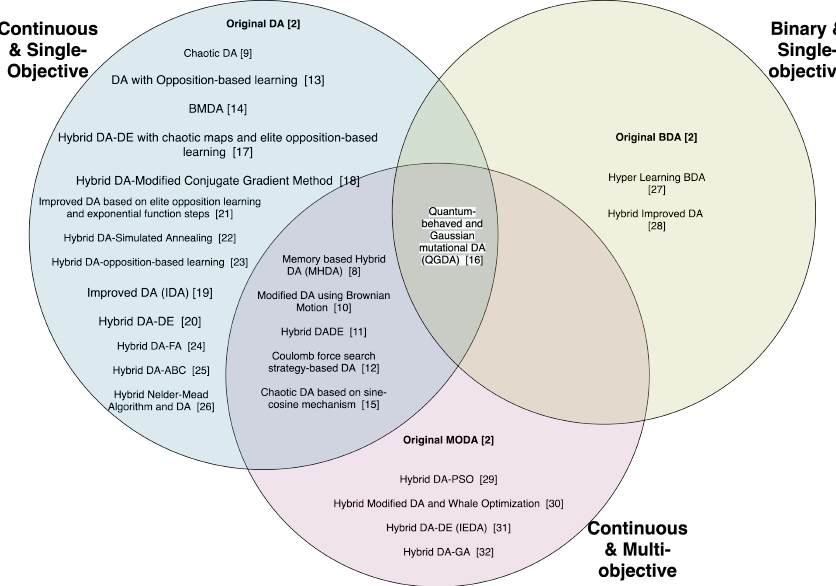
Figure 4. Taxonomy categorizing hybrids of